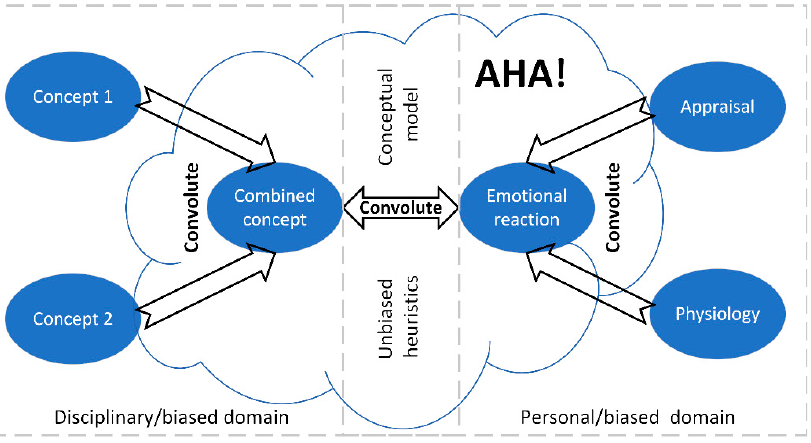
Figure 9. The Aha! experience resulting from the convolution process of concepts and emotions (adapted from [26]: Figure 2, page 10).